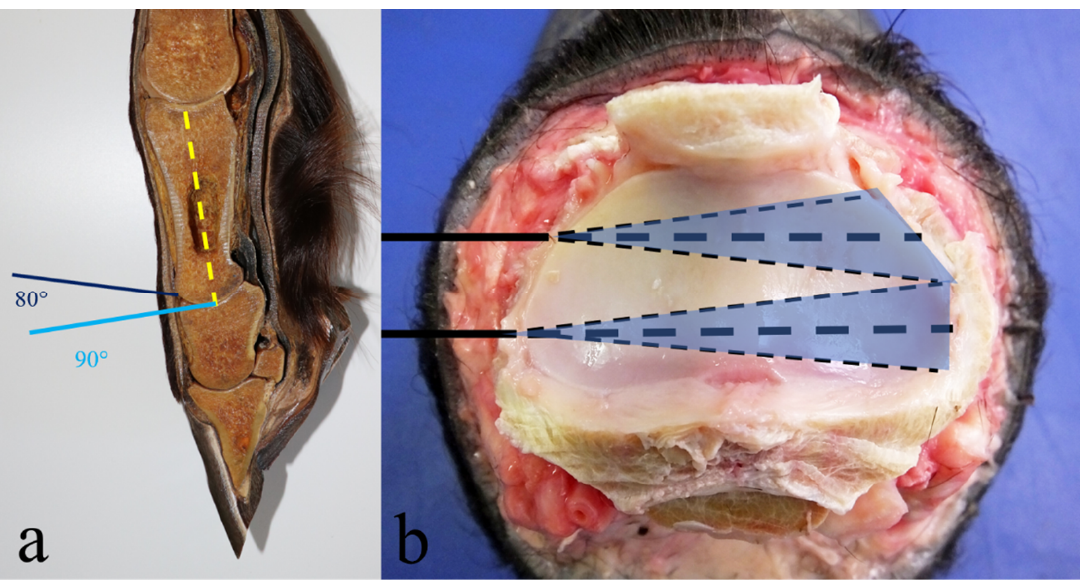
Figure 5. Dorsal drilling approach pattern, showing the entry angle into the joint (80°) and the requirement to change the drilling angle, in order to follow the articular surfaces curvature ( a ). Lateral drilling approach pattern, showing the areas interested by cartilage removal according to the movements of the drill bit ( b ).